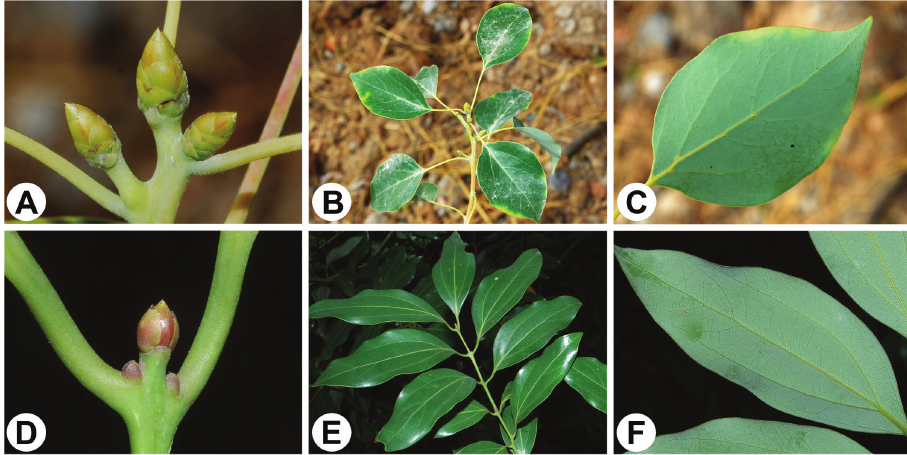
Figure 1. Morphology of the two sections of the Asian Cinnamomum A–C Cinnamomum camphora of sect. Camphora A perulate terminal buds B branch portion displaying the alternate leaf arrangement C a leaf showing the pinnate venation and the domatia in axils of lateral veins D, E Cinnamomum japoni- cum of sect. Cinnamomum D terminal buds lacking helically arranged scales E branch portion exhibiting the subopposite leaf arrangement F a leaf displaying the tripliveined venation and the absence of domatia in axils of lateral veins.